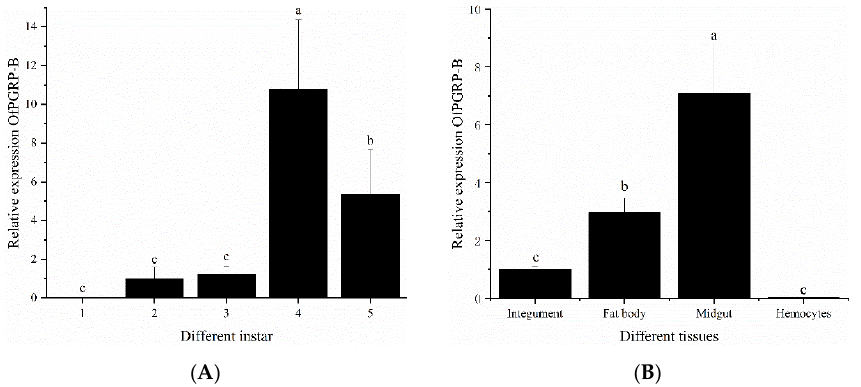
Figure 4. Relative expression levels of OfPGRP-B in different developmental stages ( A ) and adult tissues ( B ) of Ostrinia furnacalis . The small letters represent a signifificant difference (one-way ANOVA, followed by Tukey’s test as post hoc, p < 0.05).